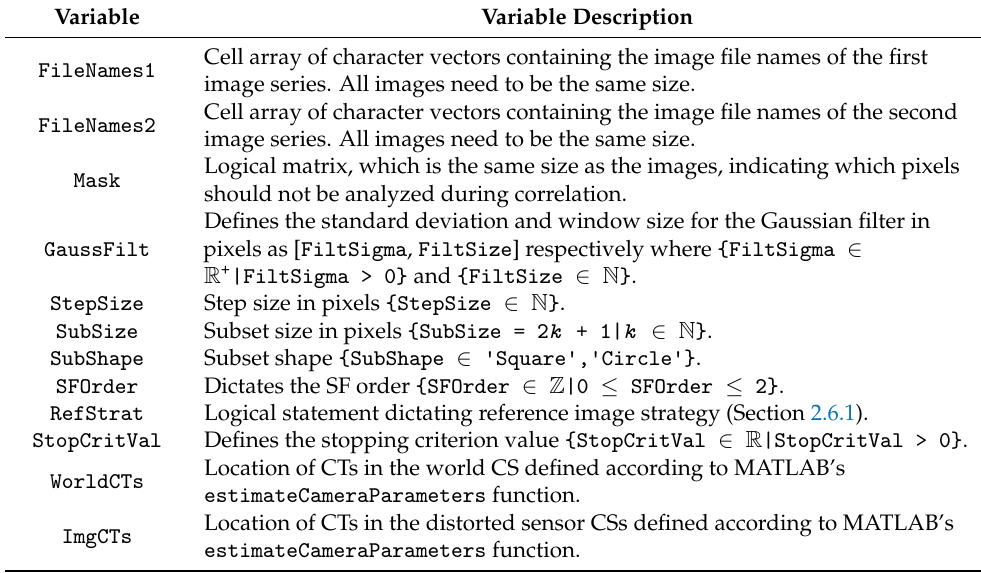
Table 1. Required input variables of the ADIC3D framework.